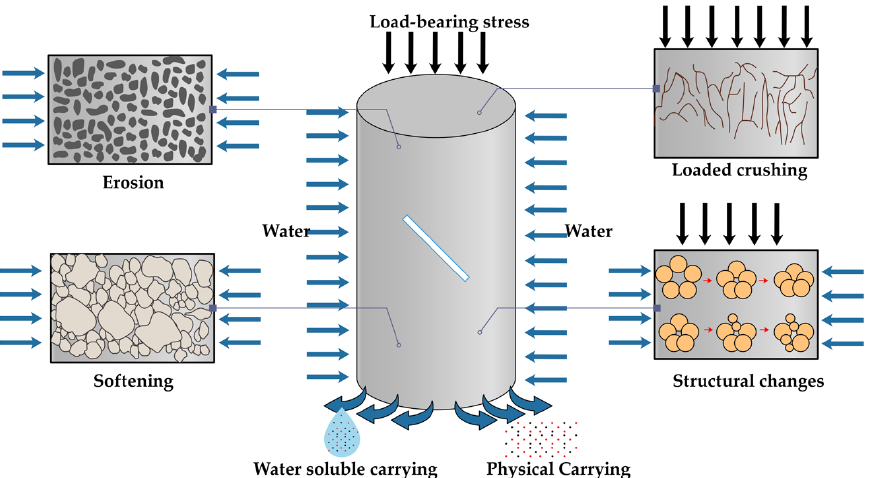
Figure 4. Coupling damage and pore space changes in fracture-grouted body during wetting–drying cycles.